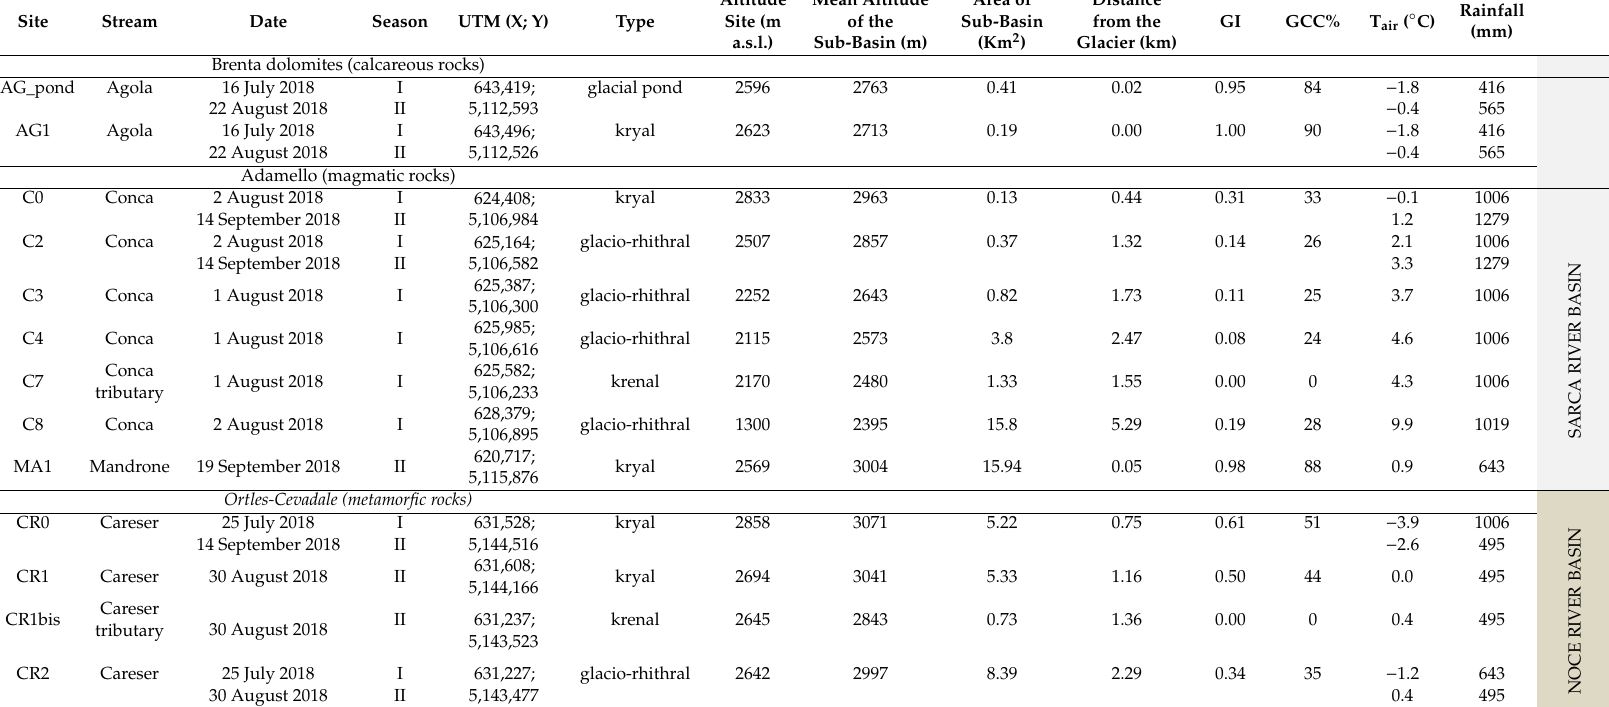
Table 1. Catchment characteristic and location of the sample